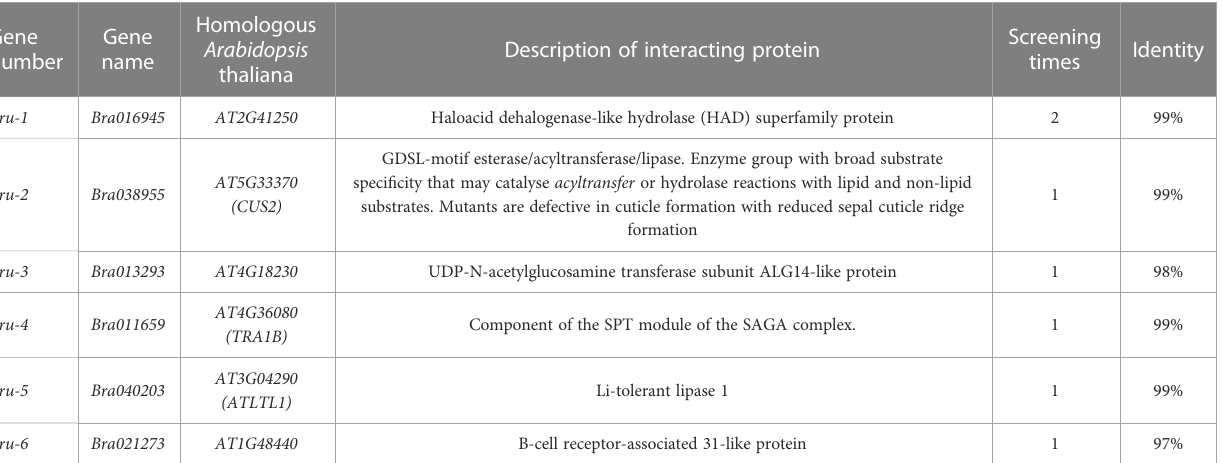
TABLE 3 Information for candidate proteins that interacted with BrUFO.